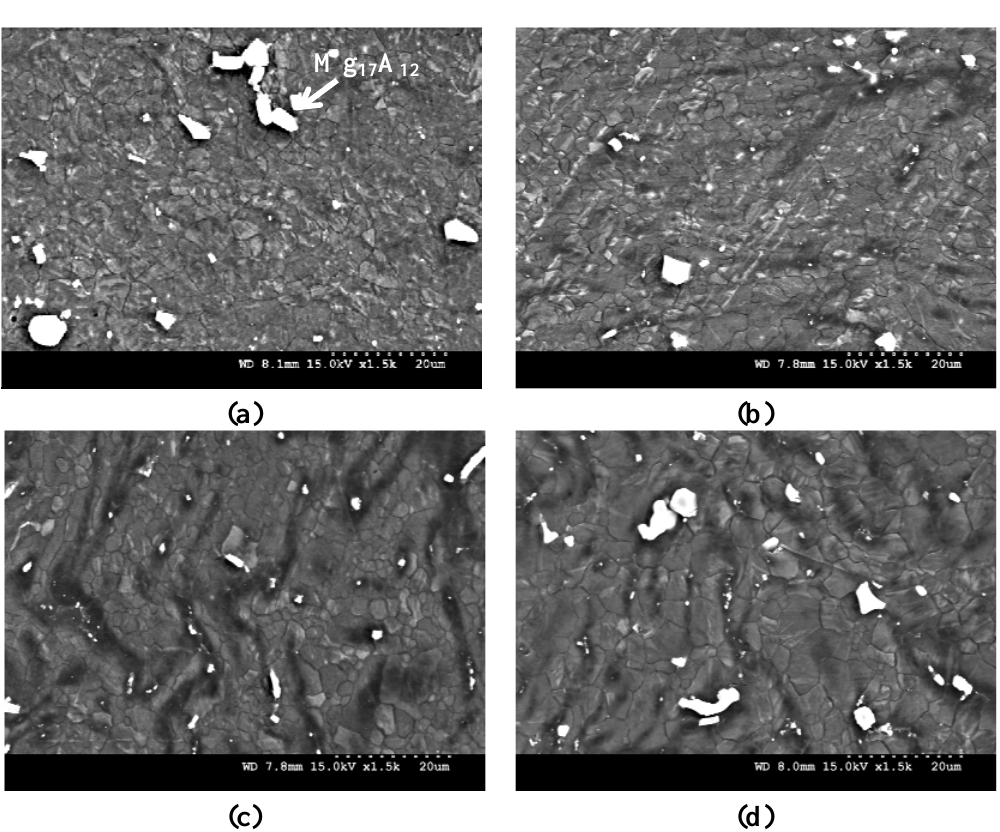
Figure 1. Field Emission Scanning Electron Microscope (FESEM) micrographs showing the grain size and second phase distribution in: ( a ) AZ41; ( b ) AZ41 + Y ( d ) AZ51 + Y O 2 3